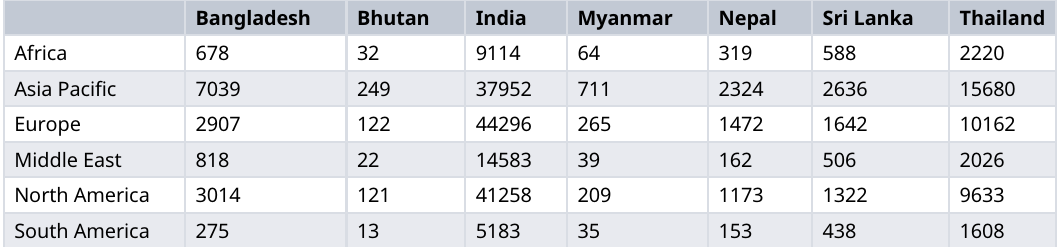
Table 2. Comparison of international collaboration publication of BIMSTEC